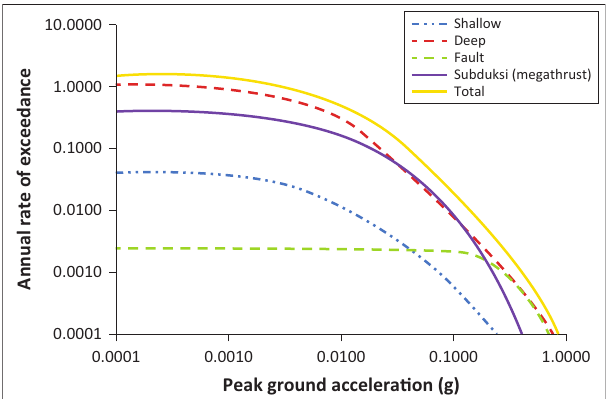
FIGURE 3: Hazard curve.